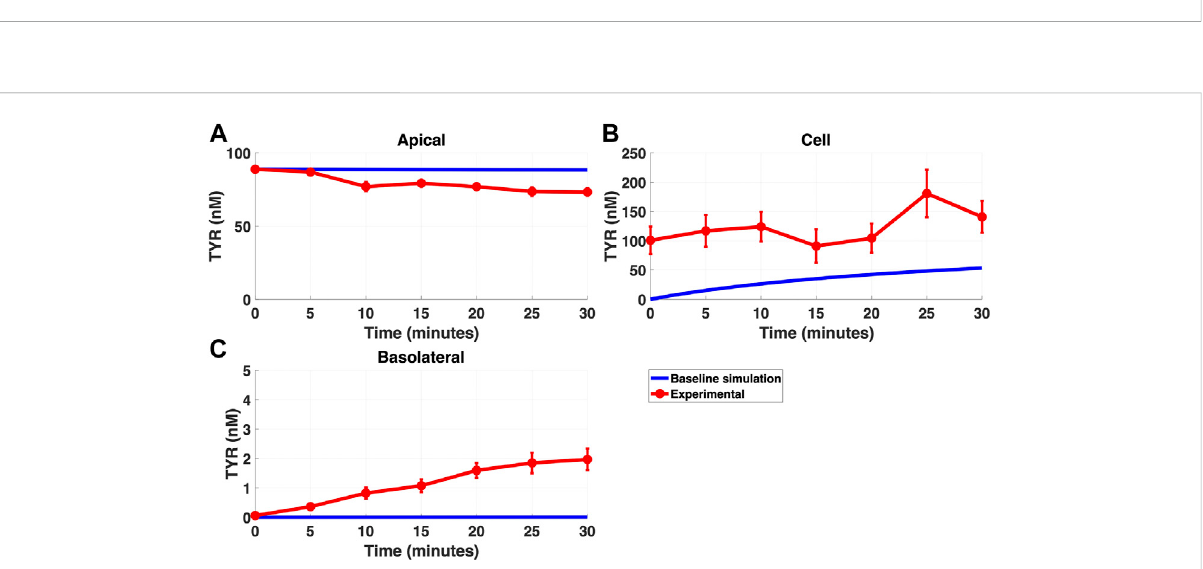
FIGURE 3 The baseline model does not fully recapitulate experimental data for TYR transport following apical loading. The transport of 88.9 nM TYR across Caco-2 cells was modeled for apical loading by solving Eqs 4 – 6, using the values mentioned in Supplementary Table S2, using MATLAB vR 2021a. Comparisons were made between the baseline model (representing known TYR transporters been characterized; blue curve) for the apical Figure 3 (A) , cellular Figure 3 (B) and basolateral compartments Figure 3 (C) , versus experimental observations; red curves (Sarkar and Berry, 2020). Kinetic parameters used for this modelling were: V max_OCT2 = 0.1 nM/s, K t _OCT2_apicaltocell = 101.5 nM, V max_baso_active = 43.0 nM/s and K t_baso_active = 33.1